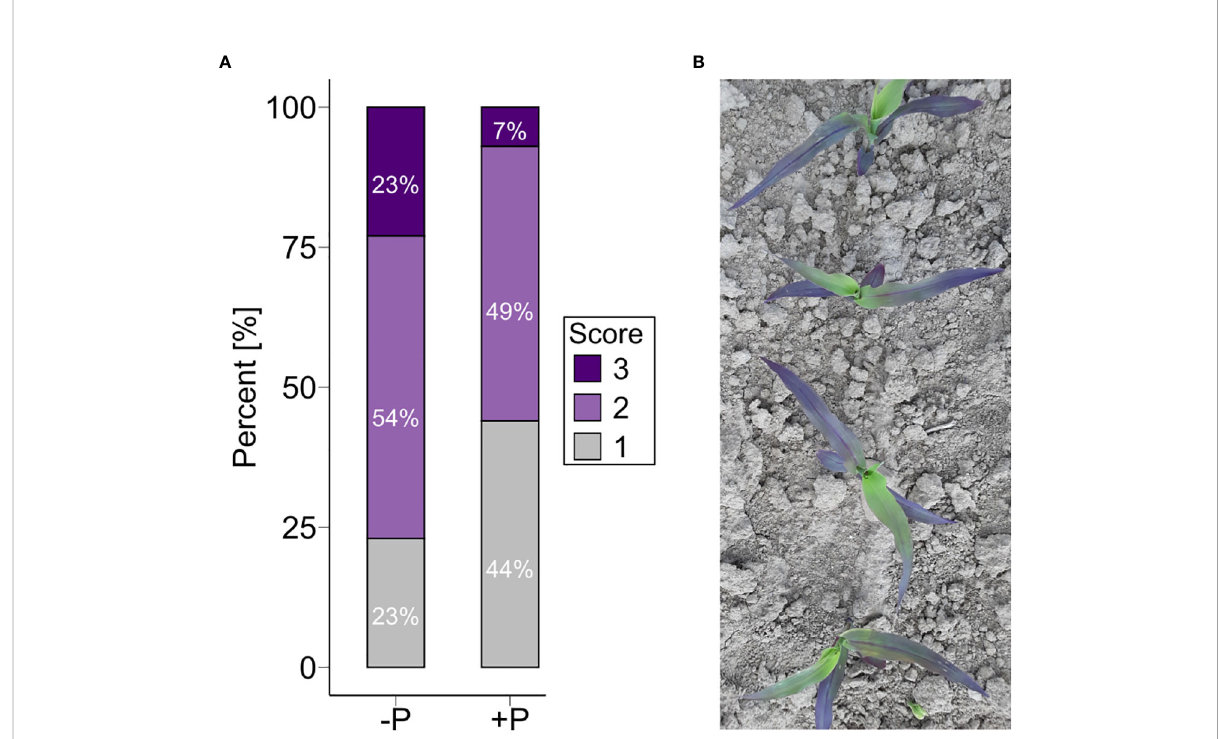
FIGURE 1 Proportion of plants with purple coloration of the leaves dependent on the P condition. (A) Purpleness evaluated in HOH20 by visual scoring on a plot basis from 1 = none to 3 = dark purple. P treatments are denoted as -P (without) and +P (with starter fertilization). (B) Discoloration of maize plants grown in -P